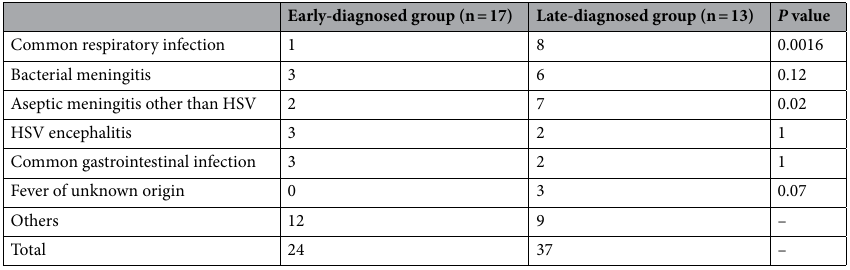
Table 2. Frequency of common misdiagnoses in the overall early-diagnosed and late-diagnosed groups. HSV herpes simplex virus.